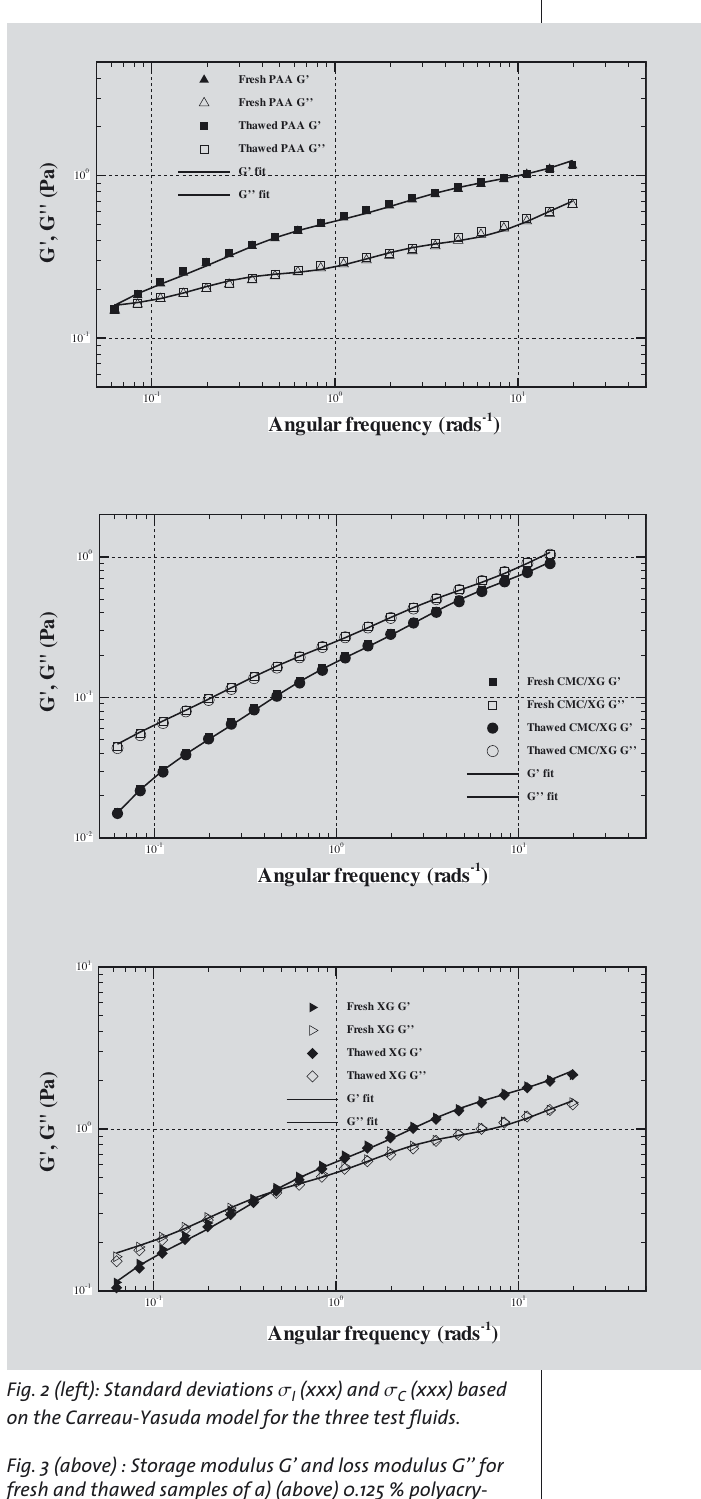
Fig. 2 (left): Standard deviations s I (xxx) and s C (xxx) based on the Carreau-Yasuda model for the three test fluids. Fig. 3 (above) : Storage modulus G’ and loss modulus G’’ for fresh and thawed samples of a) (above) 0.125 % polyacry- lamide, b) (middle) 0.1 % CMC / 0.1 % XG blend, c) (below) 0.25 % xanthan